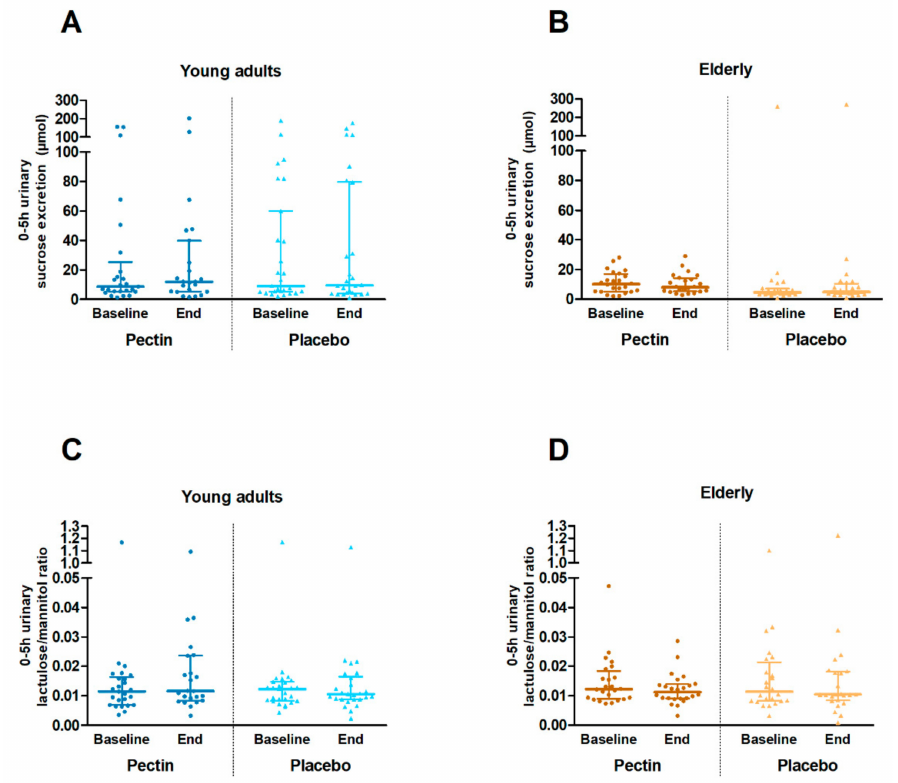
Figure 3. Gastroduodenal and small intestinal permeability in vivo at baseline and after four weeks of placebo (triangles) and pectin (circles) intervention in young adults and elderly. ( A ) 0–5 h urinary sucrose excretion ( µ mol) in young adults. ( B ) 0–5 h urinary sucrose excretion ( µ mol) in elderly. ( C ) 0–5 h urinary lactulose / mannitol ratio in young adults. ( D ) 0–5 h urinary lactulose / rhamnose ratio in elderly. Values are presented in scatter plots with median line and IQR (25–75th interquartile range). Sample size di ff erences between baseline and end are due to drop-outs. Within age groups, urinary sugar excretions and ratios were compared between intervention groups with an unstructured linear mixed model and correction for baseline